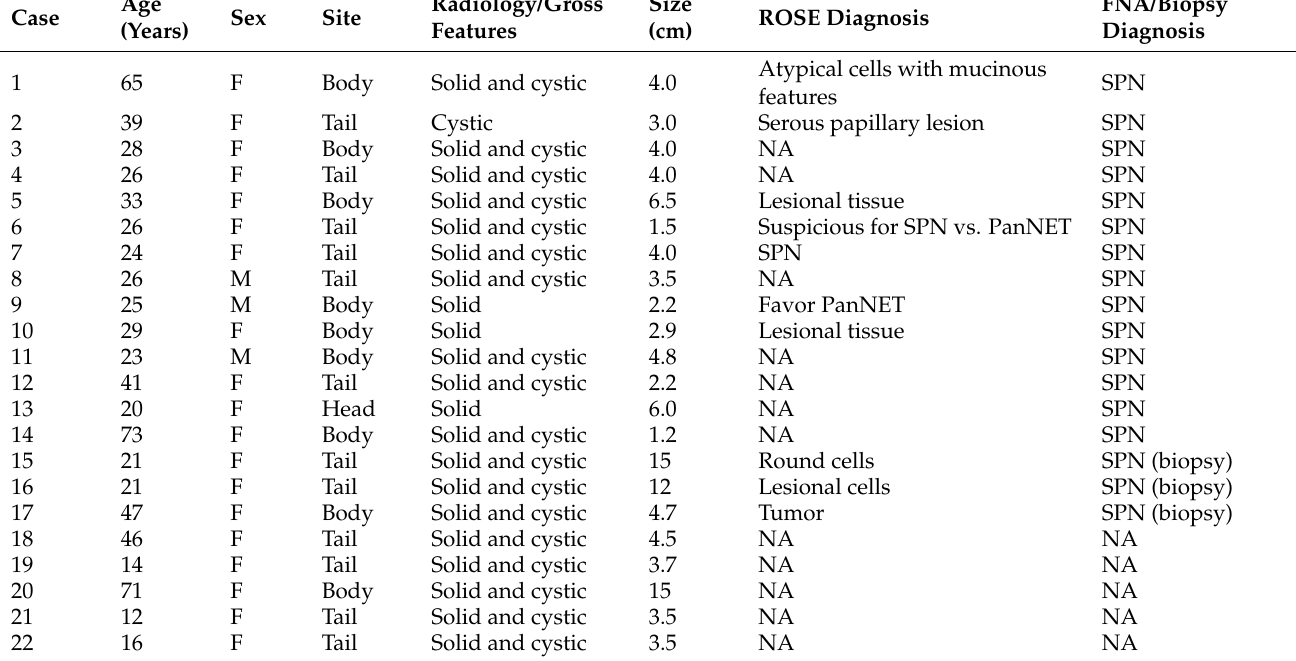
Table 1. SPN: clinical presentation, radiological/gross features, and cytological